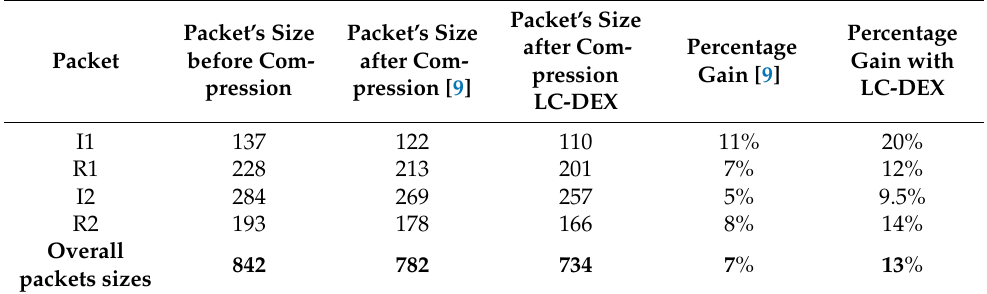
Table 5. HIP DEX handshake packets’ sizes in bytes before and after proposed